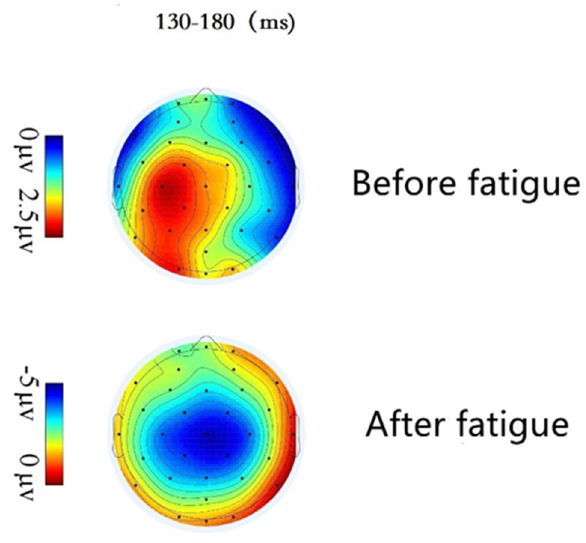
Figure 15. Brain topography in the 130–180 ms time window under standard stimulation.